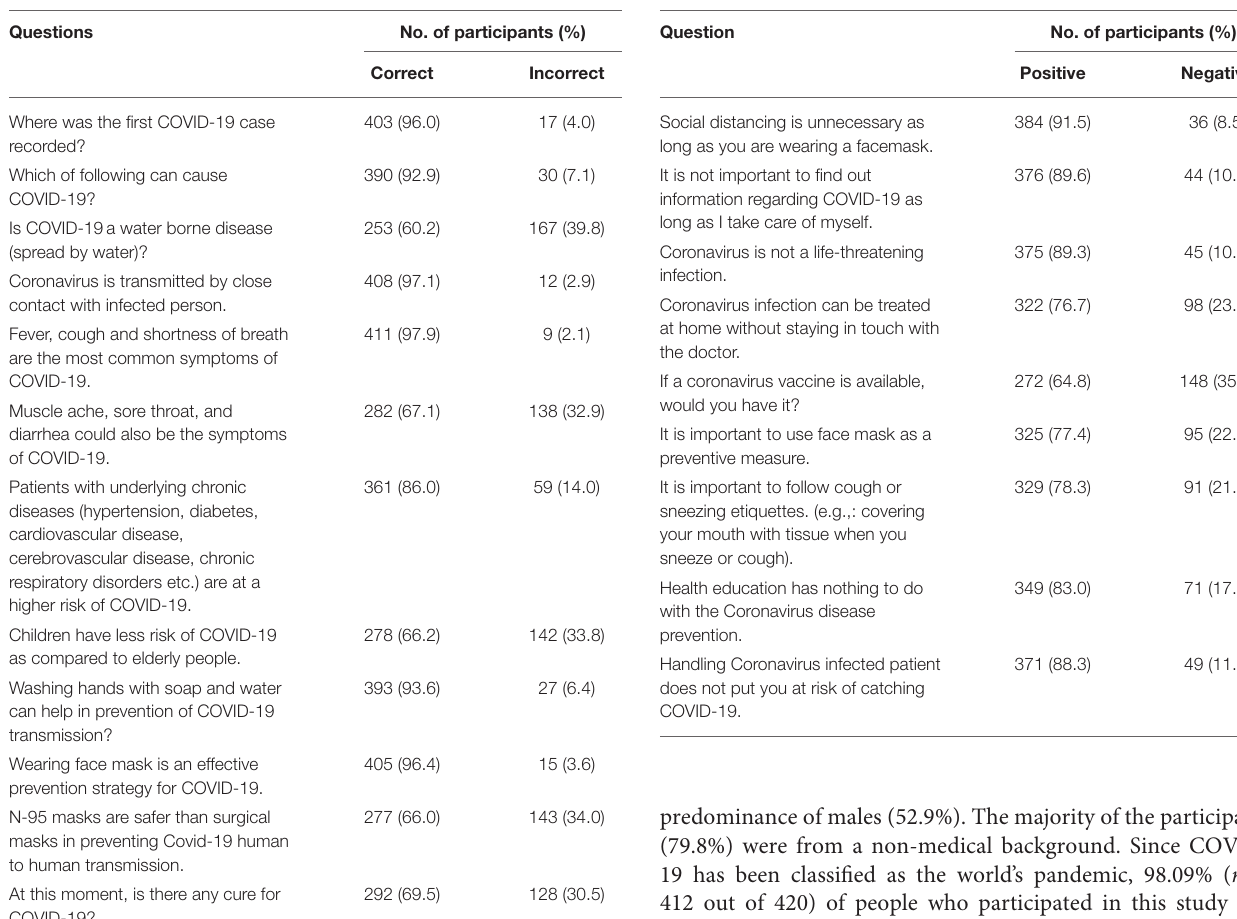
TABLE 2 | Response of study participants for COVID-19 knowledge questions. TABLE 3 | Response of study participants to COVID-19 attitude